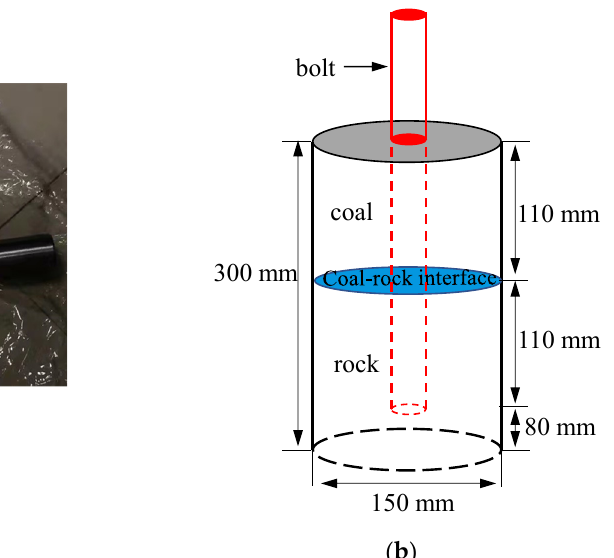
Figure 4. The dimensions of the steel rod and anchorage specimen: ( a ) the dimensions of the steel rod; ( b ) the dimensions of the anchorage specimen.